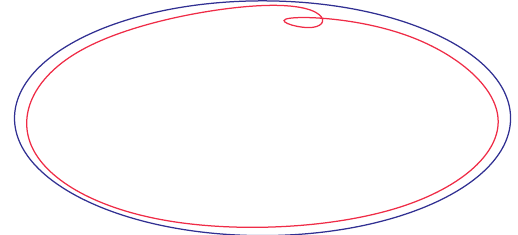
Figure 7: Curves in Example 7; curve c is blue and curve 􏽥 c is red.